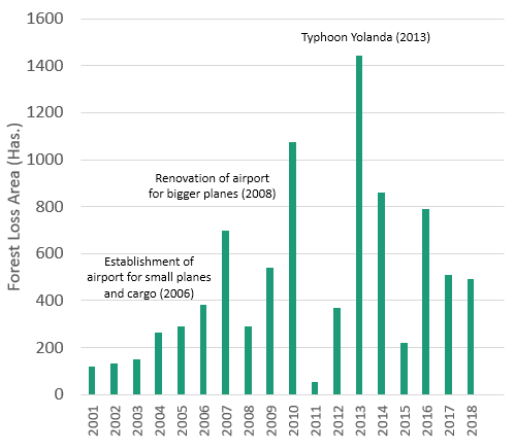
Figure 10. Yearly forest loss area in Busuanga (2001-2018) As indicated in Figure 10, the highest loss occurred in 2013 when super typhoon Yolanda ravaged the island. It is also significant to note that in 2006, an airport was established in Busuanga for cargo planes and small aircrafts. It was renovated in 2008 to be able to accommodate larger passenger planes. Based on the graph, a large increase in forest loss happened after the establishment of the airport because of growth in development and tourism on the island.